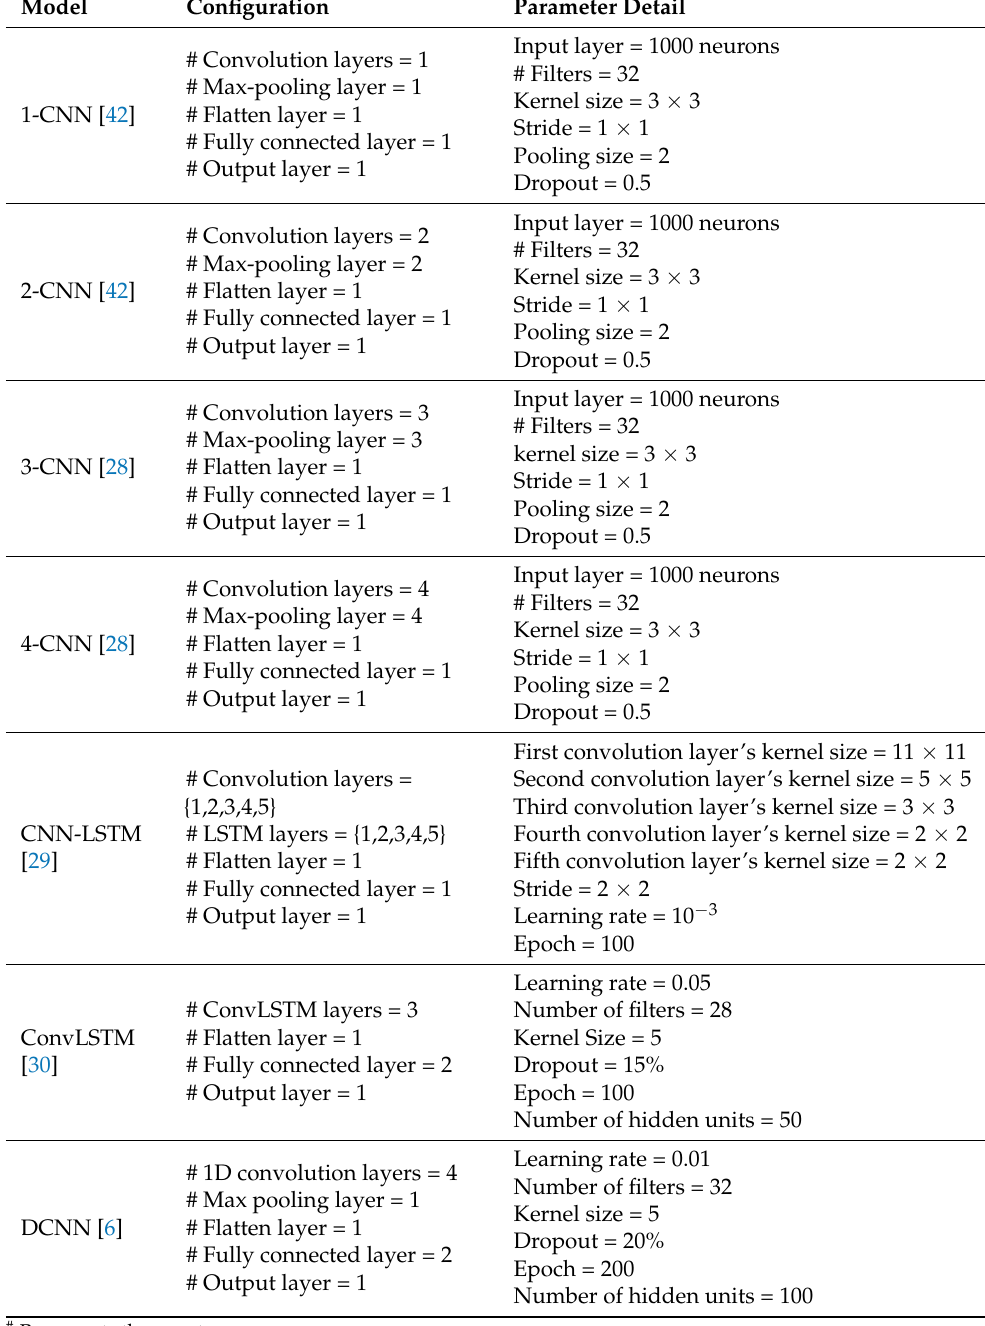
Table 4. Layer-wise configuration detail of CNN, CNN-LSTM, ConvLSTM, and